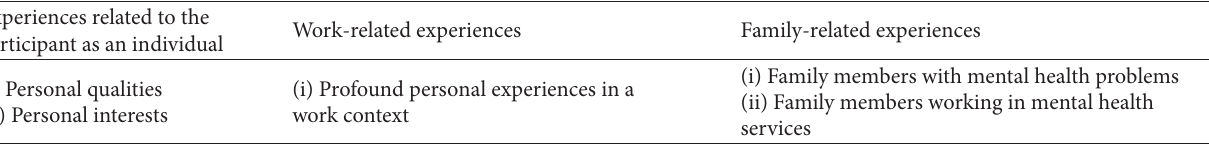
Table 2: Themes from the participants’ personal histories that were linked to their professional roles. Experiences related to